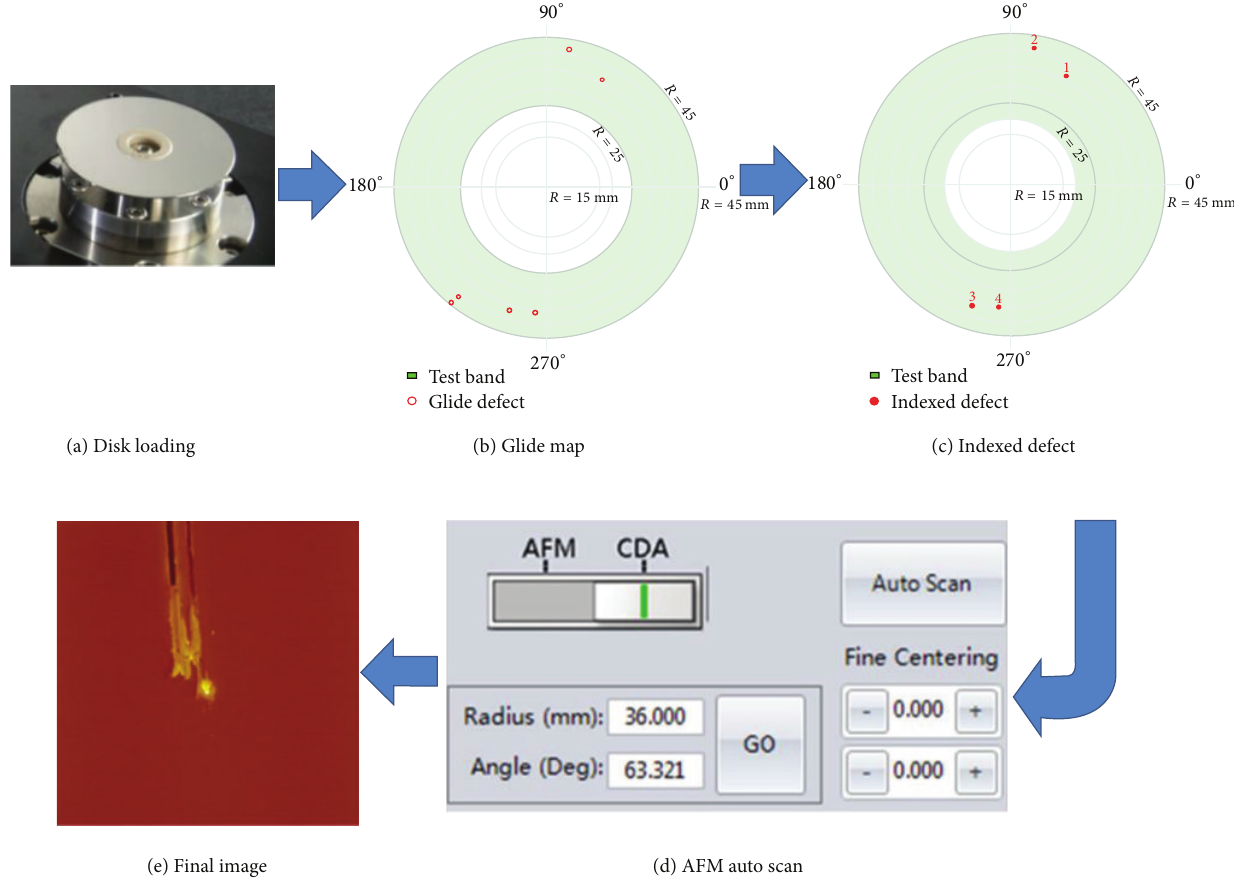
Figure 8: Test flow illustration, from sample load to AFM image. (a) Load the disk sample to the chuck. (b) Glide defect mapping from glide test. (c) Map of indexed defect from glide defect search. (d) CDA to AFM switch panel. A simple press of the “Auto Scan” button will start the automatic AFM scan routine. (e) Final AFM image of one of the scanned